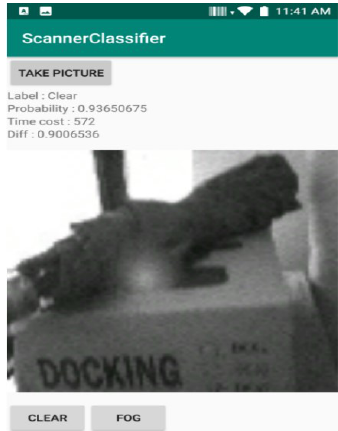
Figure 3. Data collection app: It takes a picture, resizes it, and collects the human-provided label to be associated with it.